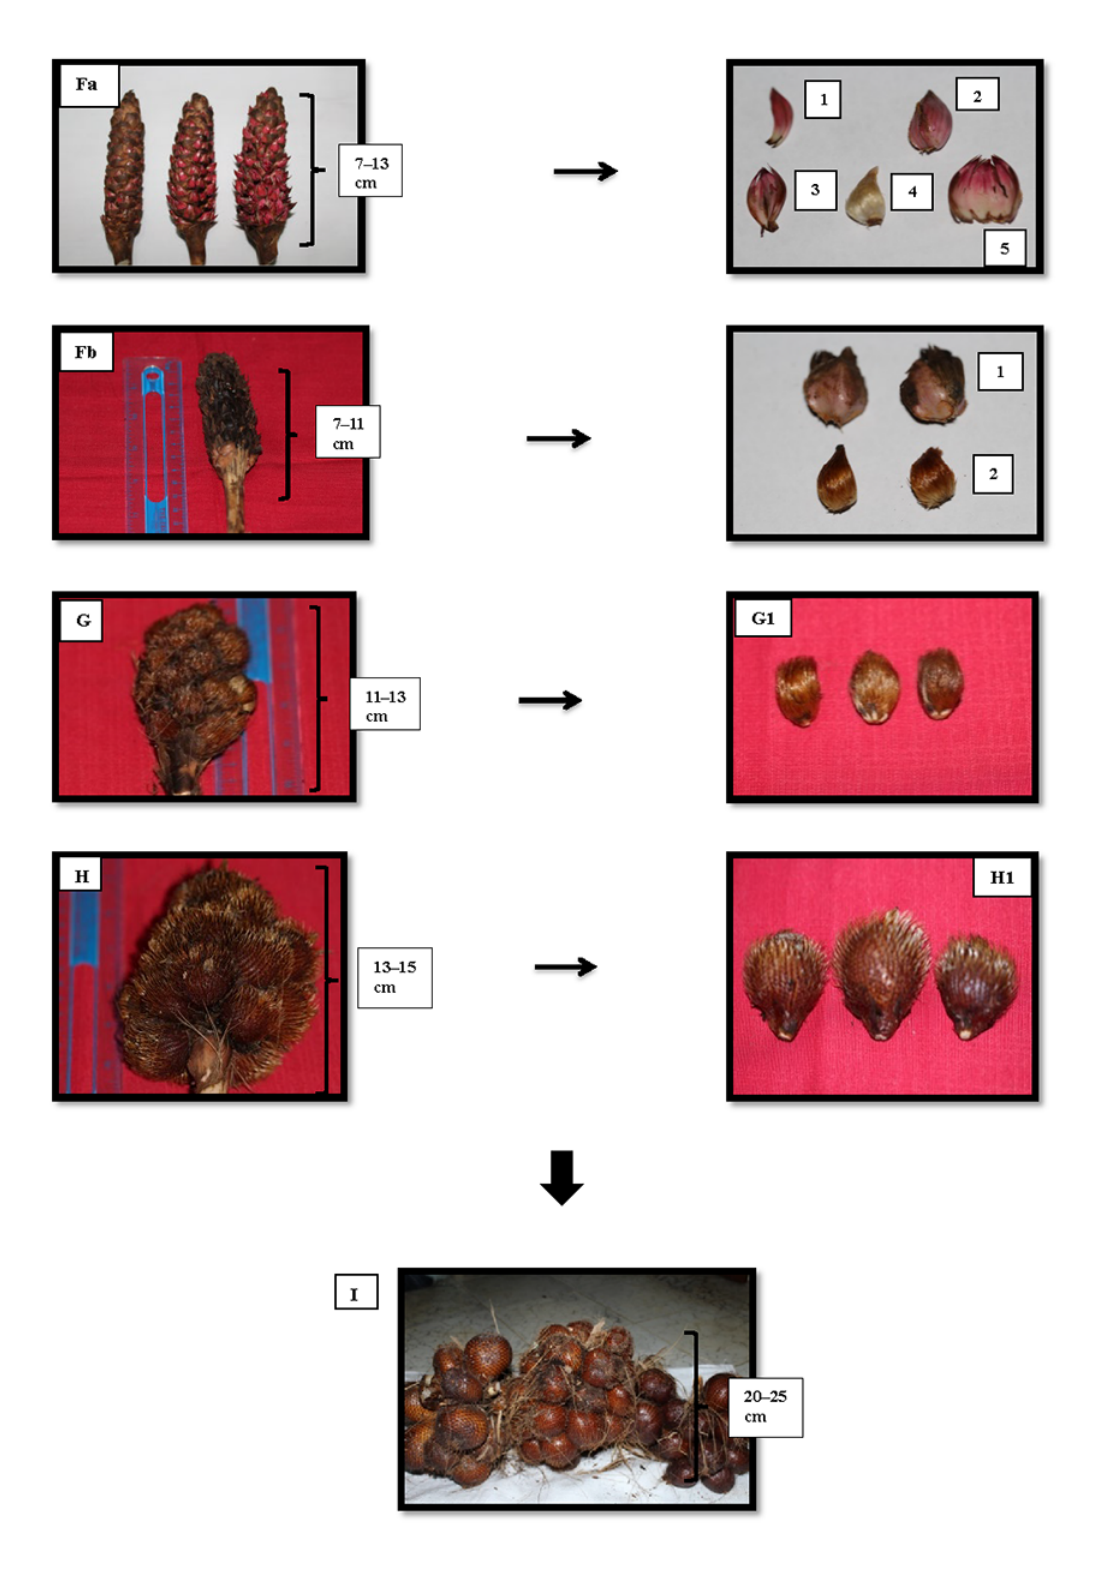
F igure 4 Fruit bunches from Phase F to I of Sidimpuan snake fruit ( Salacca sumatrana Becc.). Note: Fa = 6th phase of flowering and fruit set; Fa1–5 = individual flowers in Phase 6: 1 = staminate flower; 2 = pistillate flower; 3 = staminate flower with stamen; 4 = formed fruit; 5 = sheath of a pistillate flower. Fb = 6th phase of flowering and fruit set: 1 = fruit formed in the sheath; 2 = fruit formed with sheath removed. G = fruit bunches in the 7th phase of fruit setting; G1 = fruit diameter 2.0–3.0 cm. H = fruit bunches in the 8th phase; H1 = 9th phase fruit with a diameter of 3.5–4.0 cm. I = fruit ready for harvest (diameter 4.0–6.0